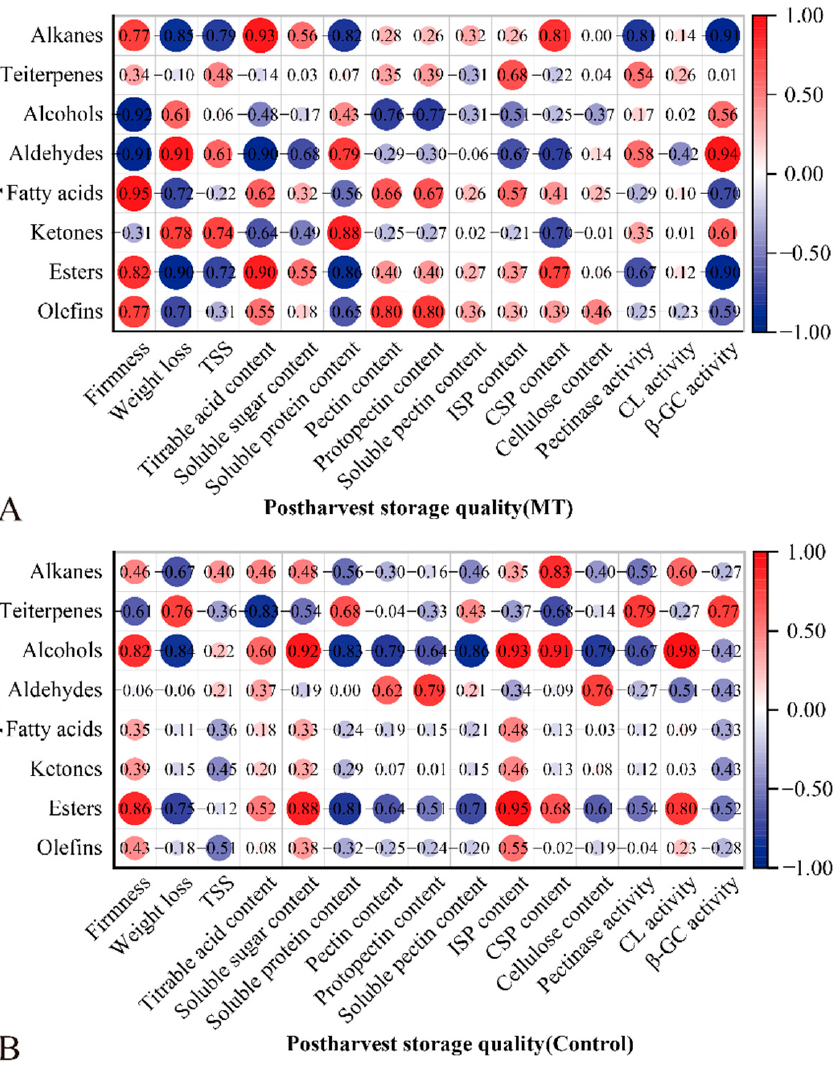
Figure 7. Melatonin treatment affects the storage quality correlation with wax components and alkanes composition. Correlation between wax components and storage quality in MT ( A ) and the control ( B ). Red and blue indicate the positive correlation coefficient and negative correlation coefficient between variables, respectively. |r| > 0.9 represents that correlation was significant.